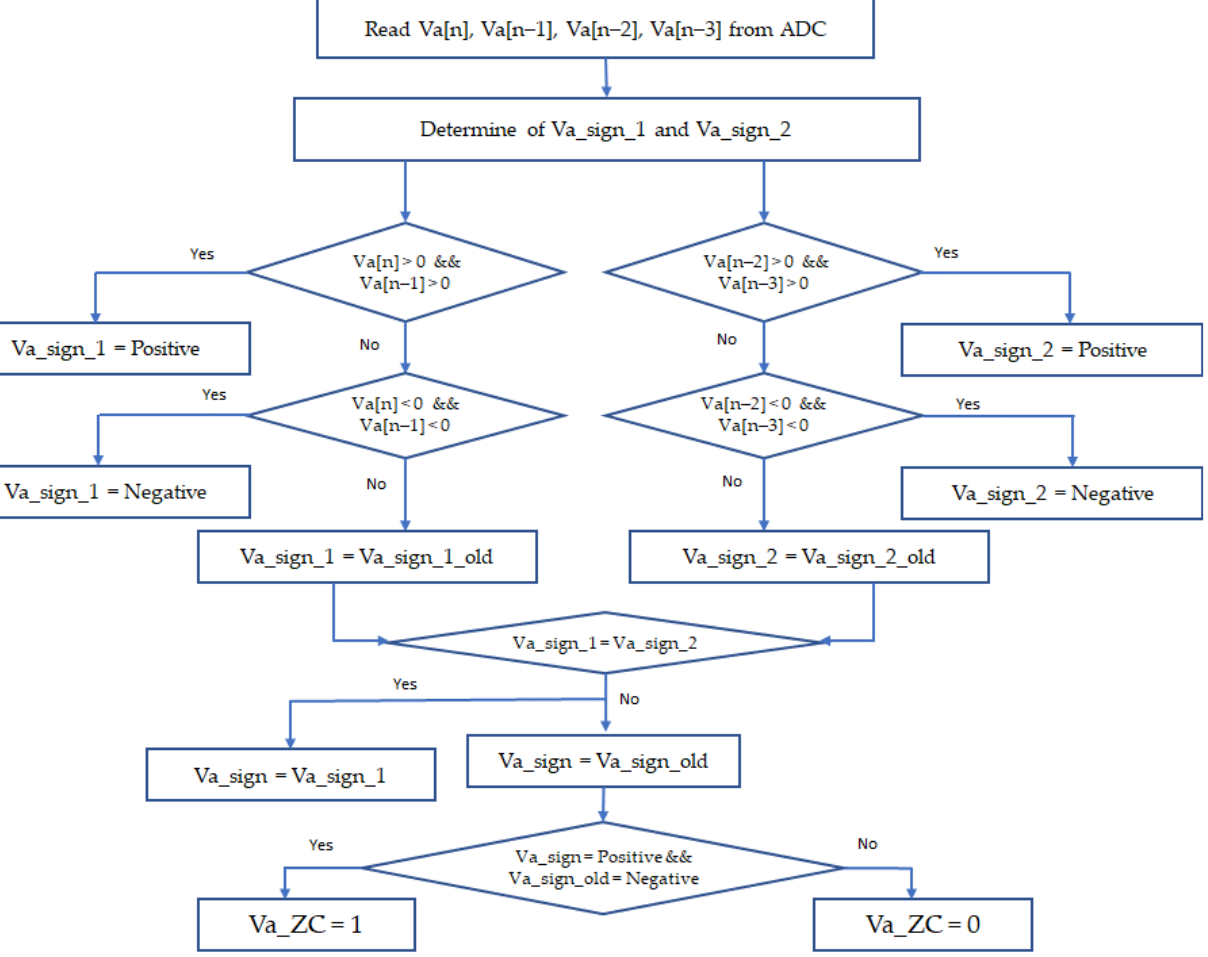
Figure 5. Flowchart of the proposed zero-crossing detection technique.